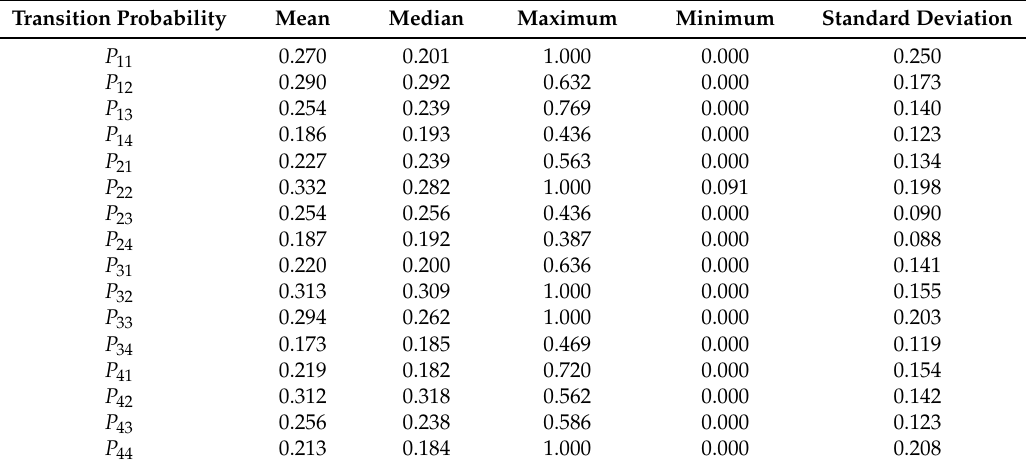
Table 1. Descriptive statistics of transition probabilities (expert opinions).